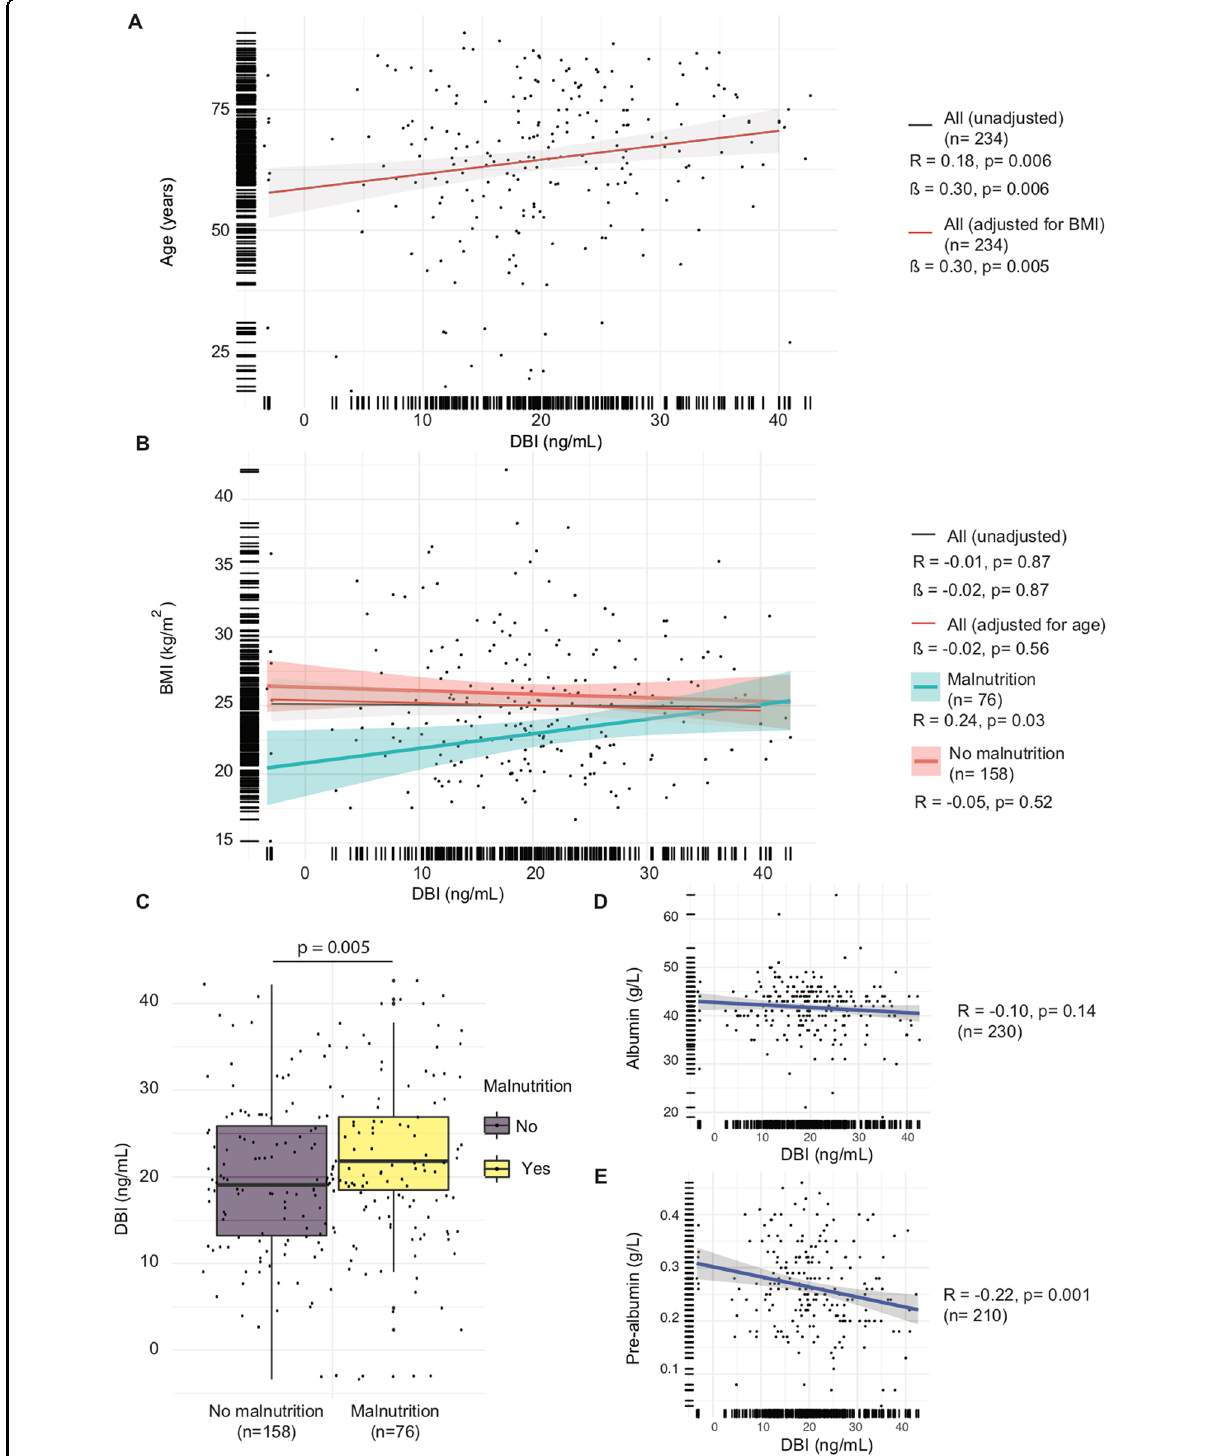
Fig. 5 ACBP/DBI correlates with age but not with BMI in patients with advanced cancer, excepted for undernourished patients. Scatter plots with regression lines between ACBP/DBI (ng/mL) and age ( A ) and BMI ( B ) before and after adjustment for BMI ( A ) and age ( B ) and in patients with and without malnutrition ( B ), and between ACBP/DBI (ng/mL) and albumin ( D ) and prealbumin ( E ) in the advanced cancer cohort. Pearson ’ s correlation coef fi cient (R) and their p value, number of samples available ( n ) and estimates (ß) from a linear model before and after adjustment are shown in the panels. Box and whisker plots represent ACBP/DBI levels (ng/mL) in patients with and without malnutrition ( C